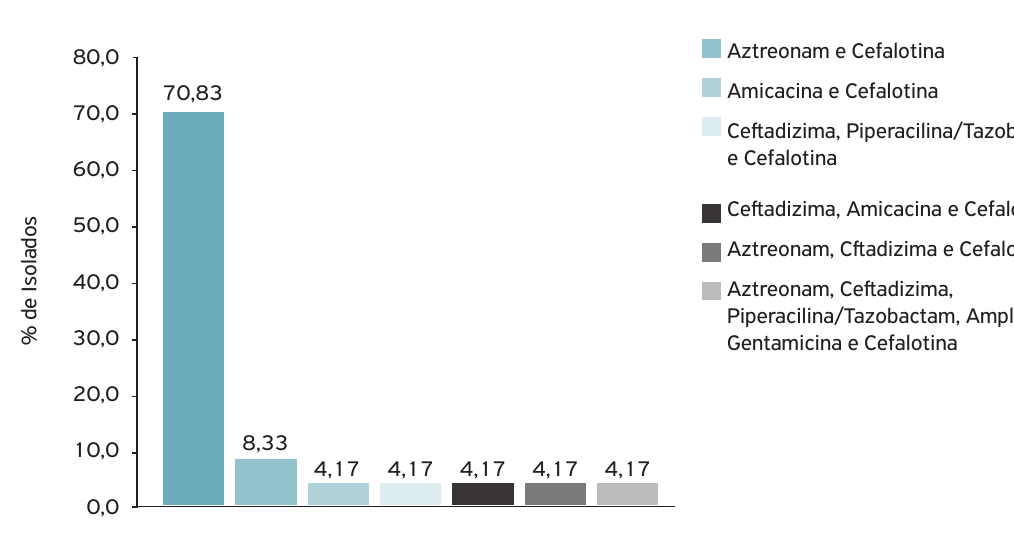
Figura 1. Multirresistência a antimicrobianos de E. coli